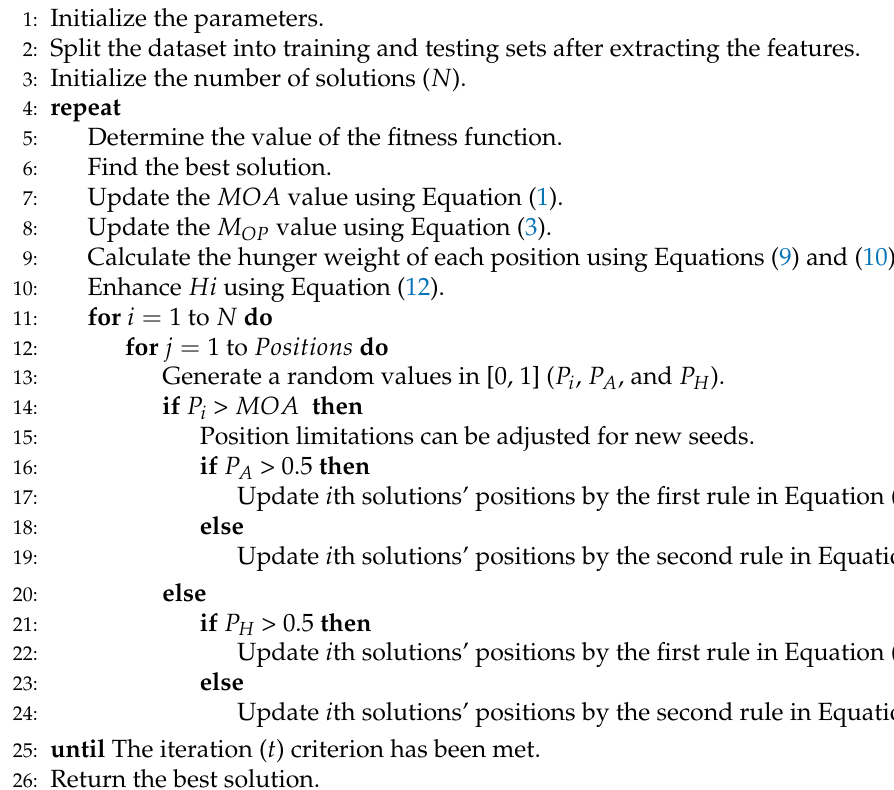
Algorithm 1 Pseudocode of the developed AOAHG